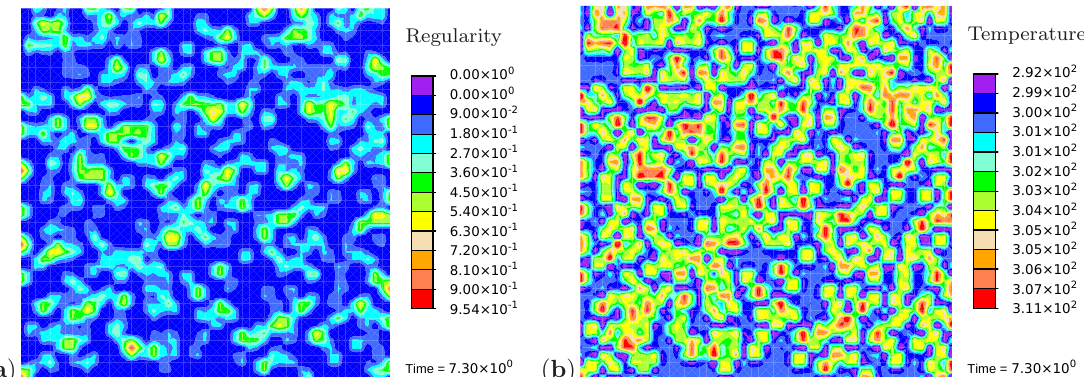
Figure 11. Cyclic tensile test with random initial microstructure. Snapshots of the microstructure evolution during the unloading stage (¯ λ = 3.7) showing ( a ) regularity distribution and ( b ) temperature distribution (in